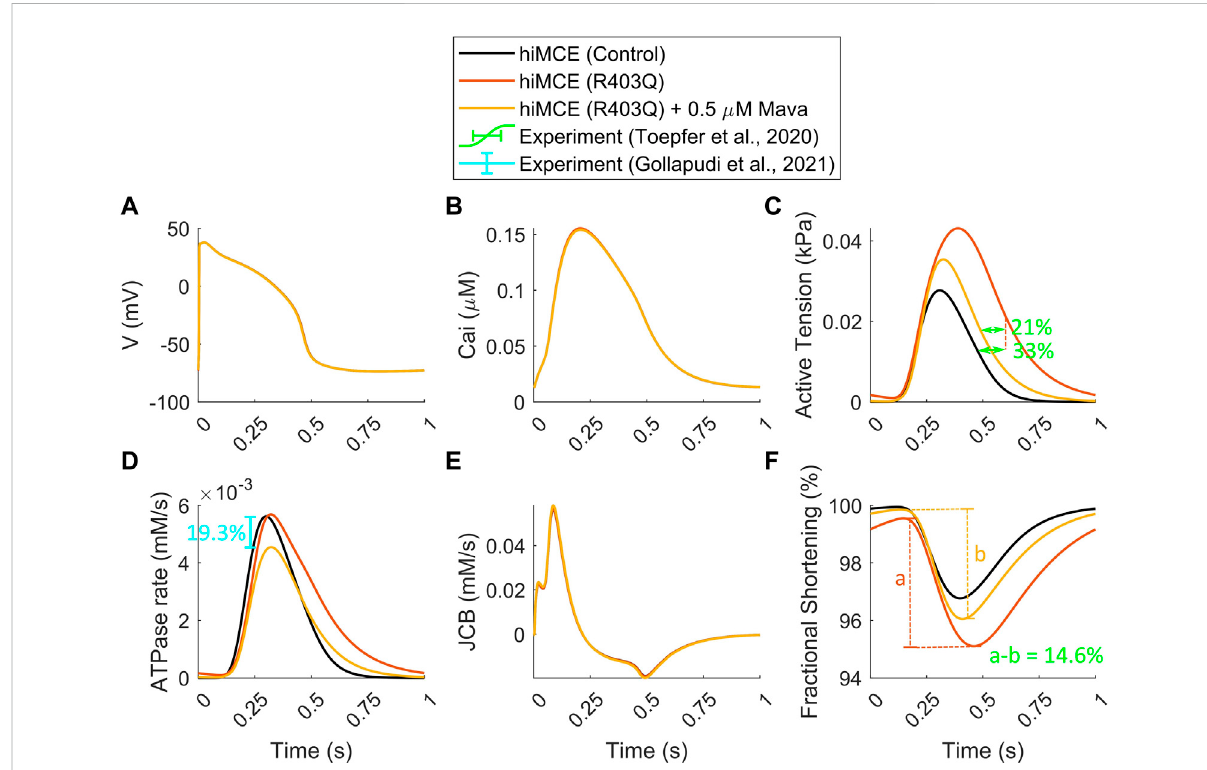
FIGURE 3 Simulated action potential (A) , Calcium transients (B) , active tensions (C) , ATPase rate (D) , Flux of Ca 2+ towards the myo fi lament (E) , and fractional cell shortenings (F) in R403Q hypertrophic cardiomyopathy and Mavacamten modes (All simulations were done at 1 Hz pacing). The percents of prolonged tension relaxation in R403Q mode (C) , the reduction in tension relaxation due to MAVA (C) , the reduction in fractional shortening inR403Qmodedue toMAVA (F) ,and thereduction inATPaseratedue to MAVA (D) agree withtheexperimentaldata (Toepfer etal., 2020; Gollapudi et al.,